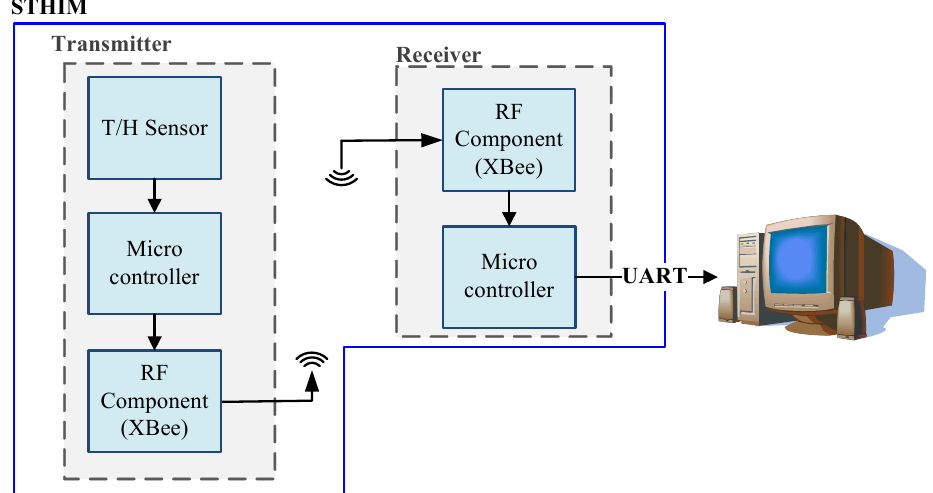
Figure 1. STHIM system block diagram.